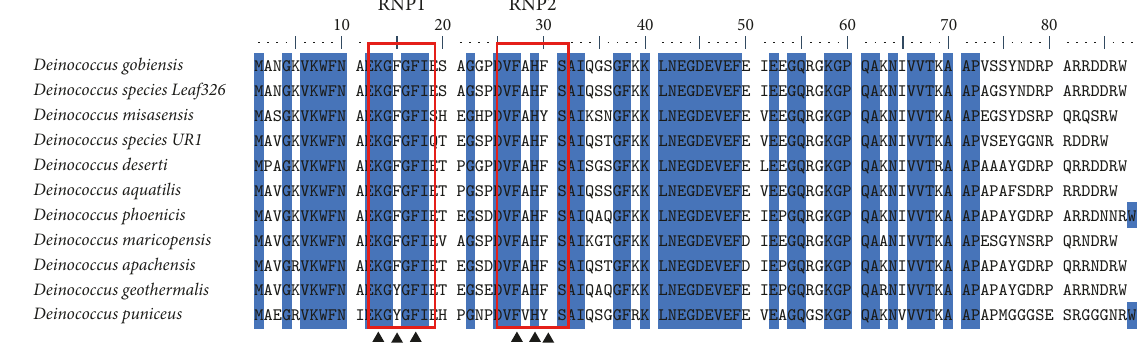
Figure 1: Multiple sequence alignment of Dm-Csp1 and related, representative Deinococci-encoded cold shock proteins . The species names are indicated. Areas of 100% conservation are highlighted in blue. The position of conserved RNA-binding motifs (RNP1 and RNP2) is enclosed within red rectangles. Conserved, basic, and aromatic residues within RNP1 and RNP2 that form a nucleic acid binding surface are indicated by